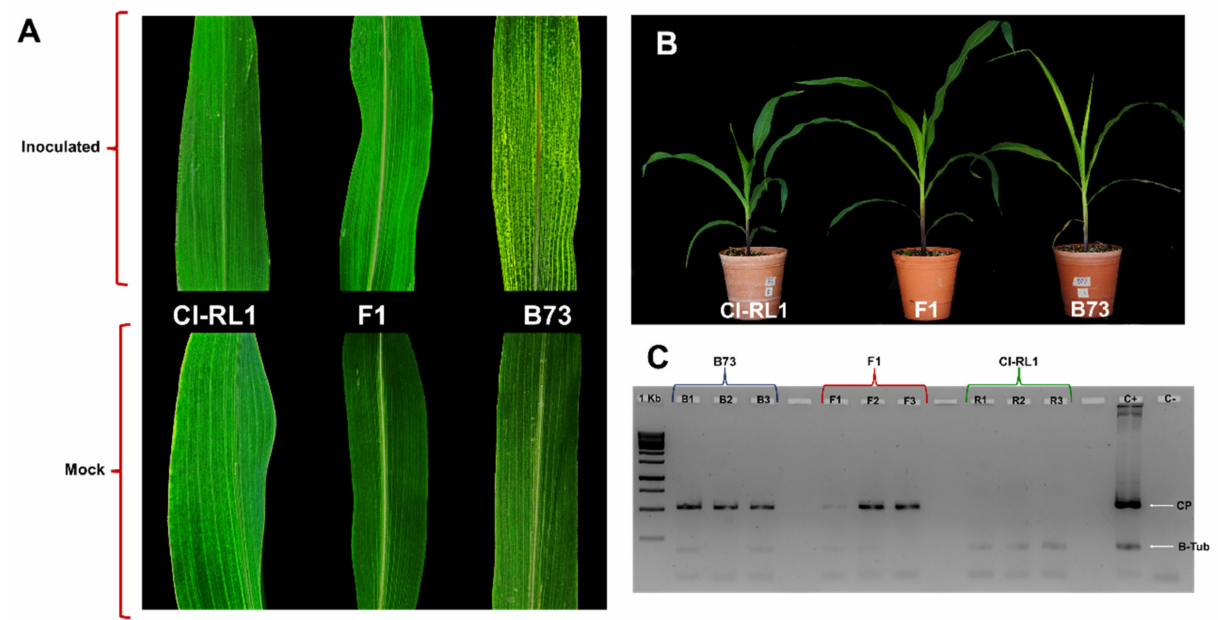
Figure 1. Symptom development and Sugarcane mosaic virus (SCMV) detection in three maize lines inoculated with SCMV isolated Veracruz 1 (SCMV-Ver1) in leaves at the same phenological stage: ( A ) B73 susceptible-symptomatic line, with chlorotic mosaic symptoms, and CI-RL1 and F1, without evident symptoms; ( B ) SCMV-Ver1-infected plants (CI-RL1, F1, and B73 from left to right). ( C ) Presence of the SCMV Coat Protein (CP)-cistron in three plants randomly selected from each